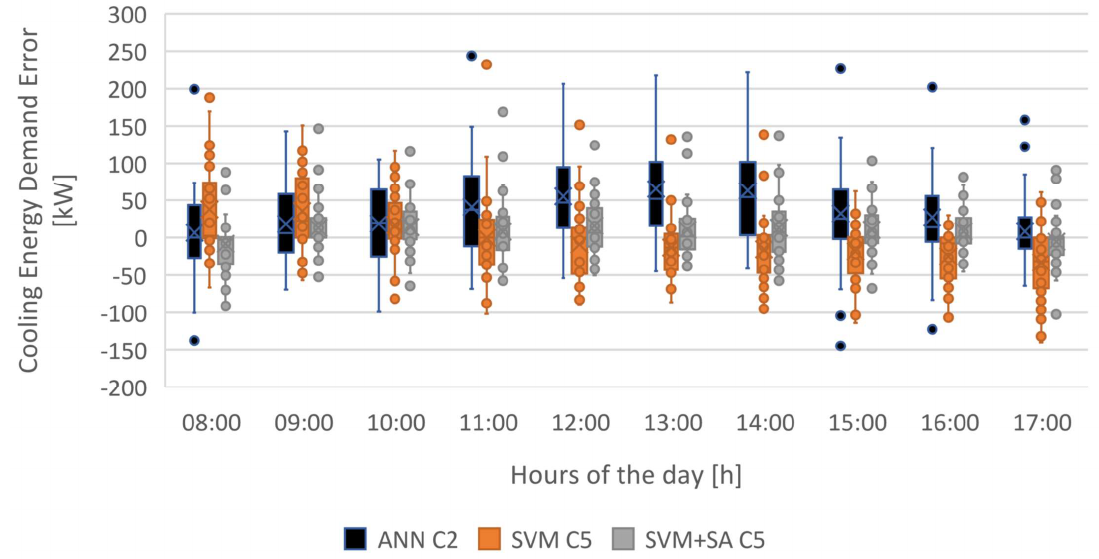
Figure 26. Error distribution for the best performing models in the cooling period. Figure 27 presents the error distribution for models ANN_H4, SVM_H4 and SVM+SA_H4 in forecasting heating energy demand, while Table 4 highlights some statistical parameters for particular hours of the day.